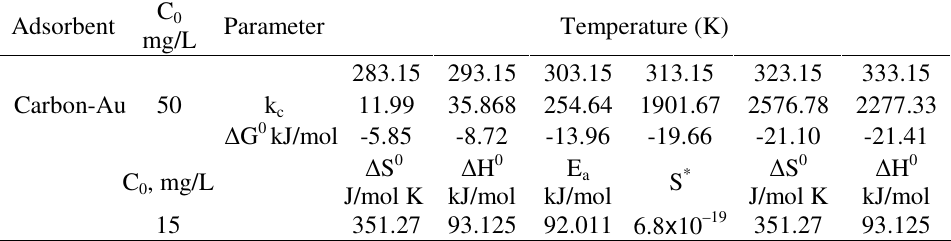
Table 3. Thermodynamic parameters for adsorption of Congo red onto 0.025 g PtNP-AC